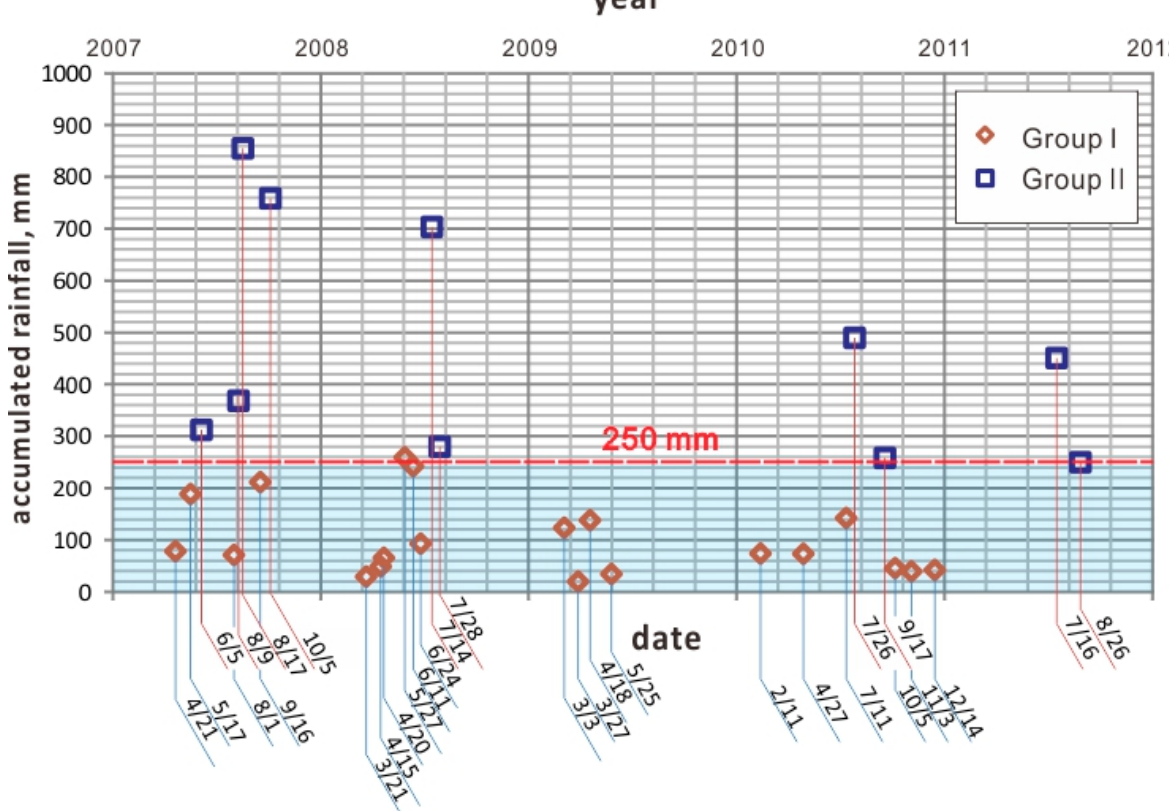
Figure 7. Comparison of the cumulative rainfall of each rainfall event with the data of the two groups at the DARB station. The threshold is 250 mm, which shows that landslides are likely to happen when the cumulative rainfall is larger than 250 mm, increasing the sediment volume in the rivers. The threshold is in good agreement with the rainfall triggering index (RTI) (250 mm) of this area published by the Soil and Water Conservation Bureau of Taiwan (SWCB) of Taiwan.